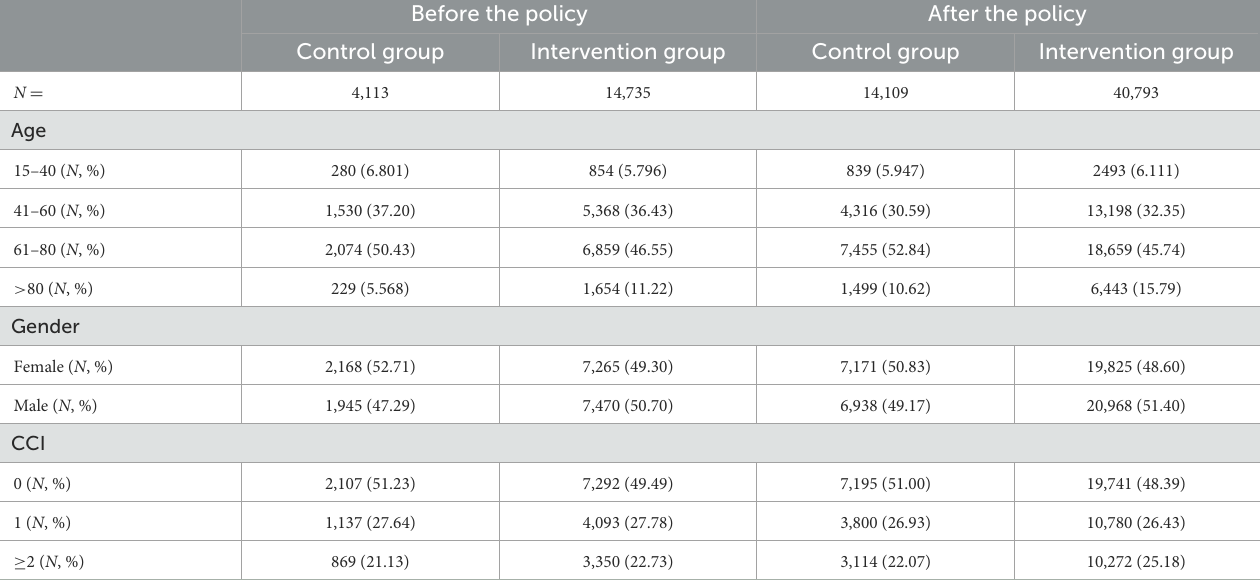
TABLE 2 Absolute changes in avoidable hospitalization rate, costs, length of hospitalization, age, gender and CCI in the intervention and control groups before and after the policy. Indicators Before the policy After the policy Difference- Avoidable hospitalization rate